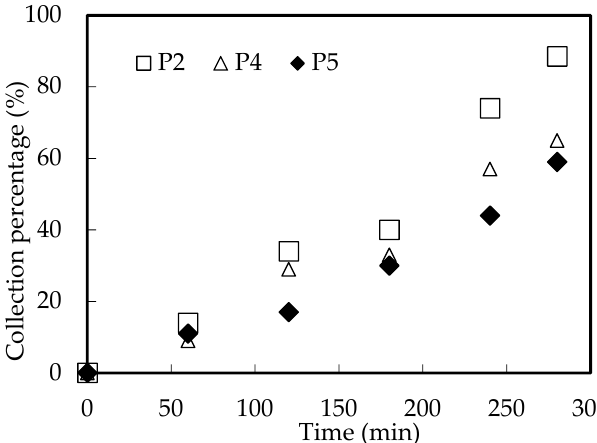
Figure 15. Influence of tube inradius.